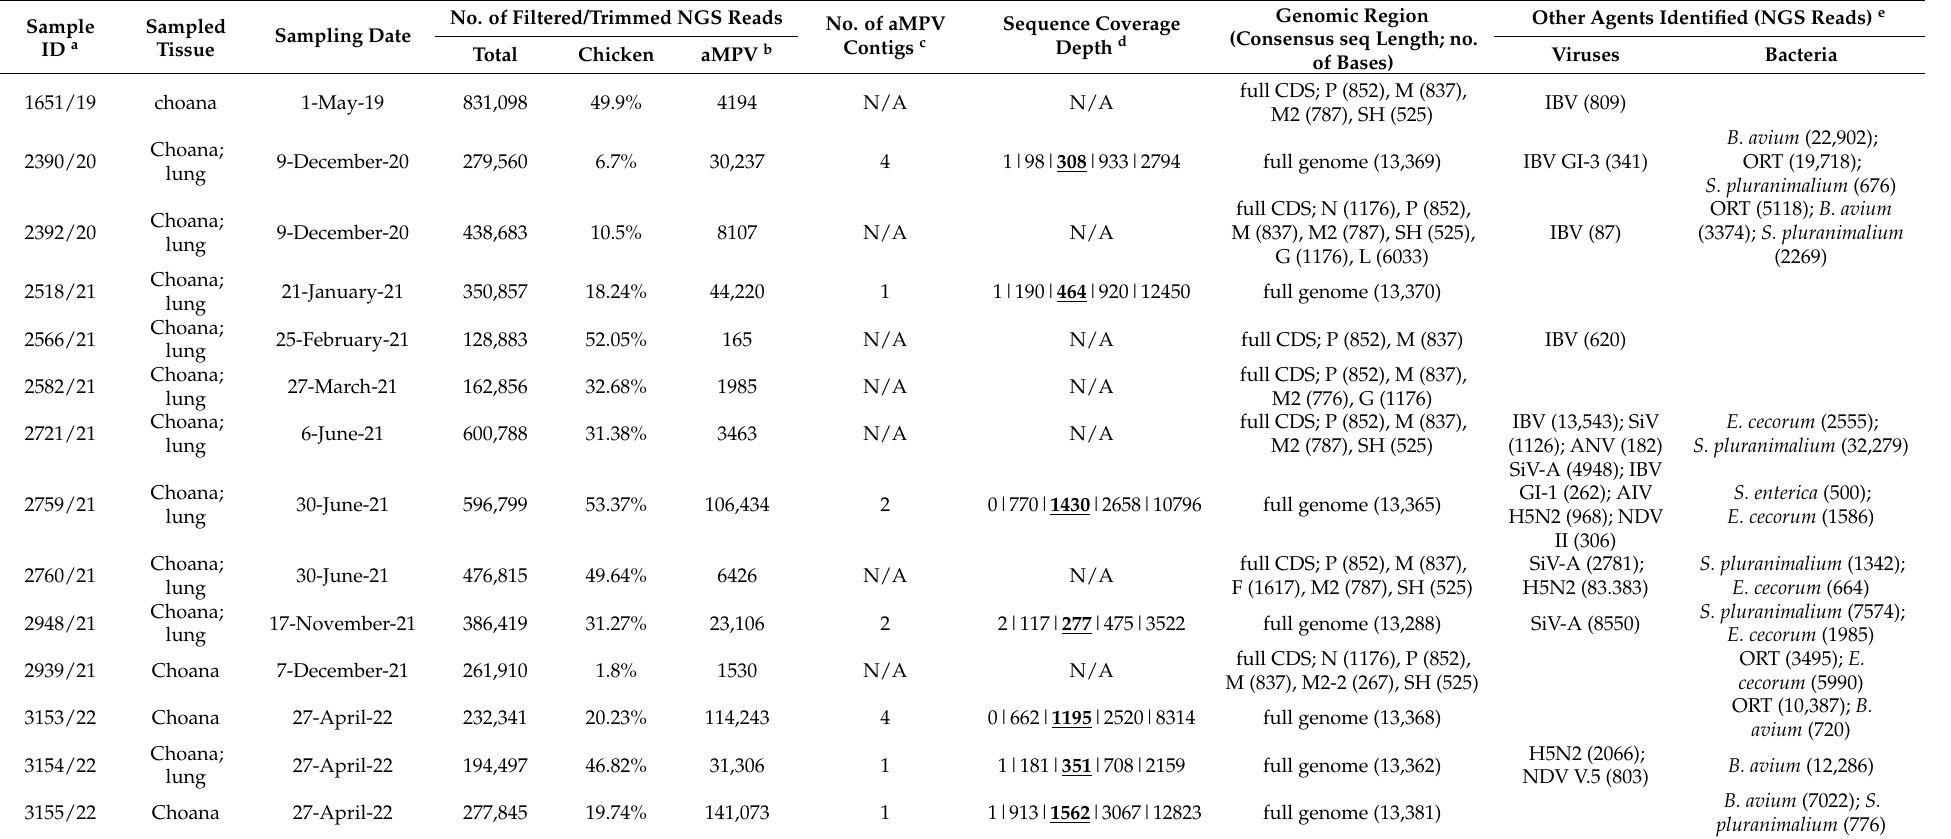
Table 1. Summary of the assembly of 14 aMPV sequences and other coinfecting microbial (viral and bacterial) agents detected in clinical samples collected from commercial broiler chickens in the current study. aMPV RNA was detected by NGS in 10.07% of the analyzed 149 respiratory (choana/lung) samples. Where applicable, viral and bacterial agents found to coinfect with aMPVs are shown. Median depth coverage of full genome sequences is highlighted (bold underlined